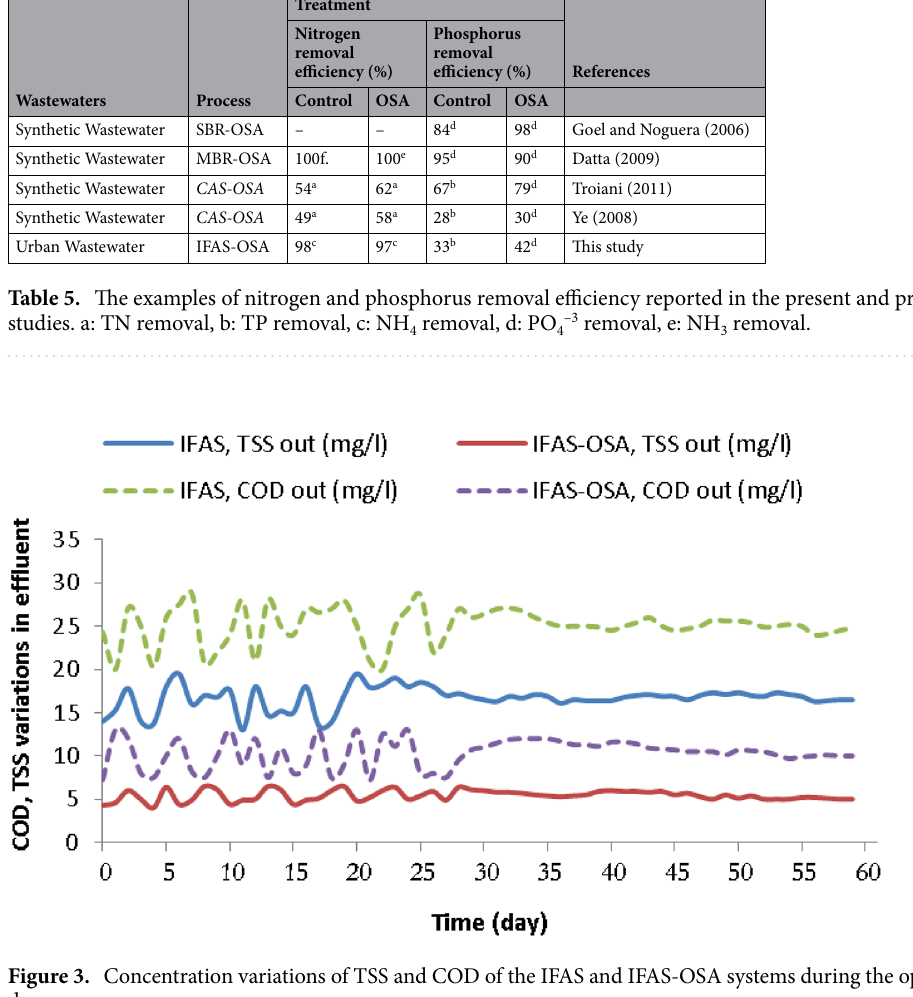
Figure 3. Concentration variations of TSS and COD of the IFAS and IFAS-OSA systems during the operation days.